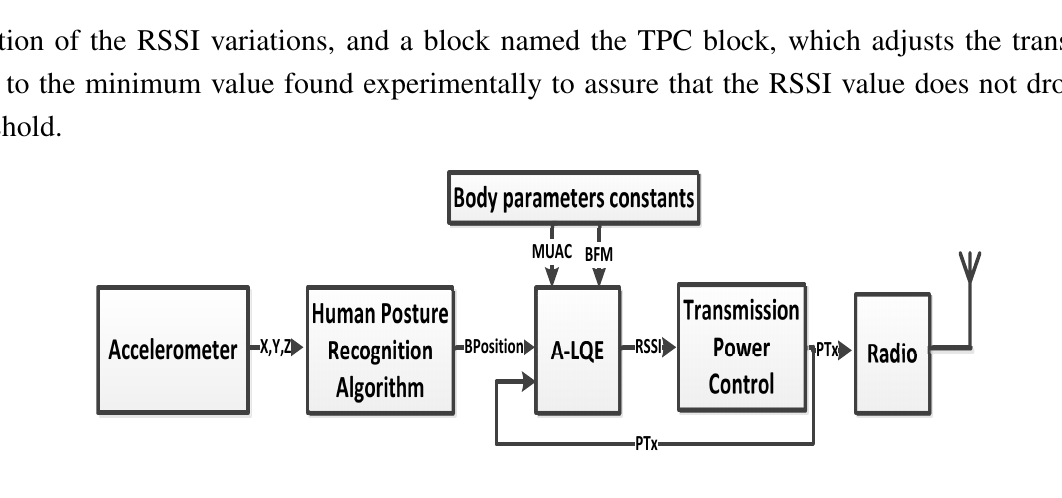
Figure 3. RSSI prediction-based transmission power control approach for Link